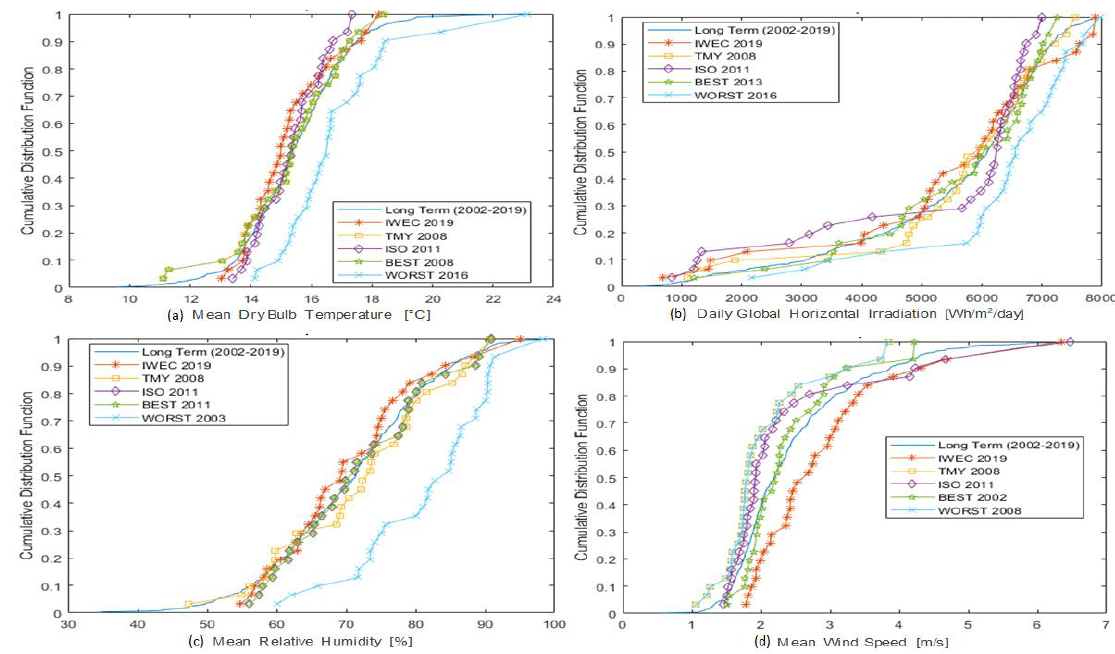
Figure 9. Cumulative distribution: Comparison among long-term measurements and selected typical months for April. ( a ) Dry bulb temperature, ( b ) daily global horizontal irradiation, ( c ) relative humidity, ( d ) wind velocity.